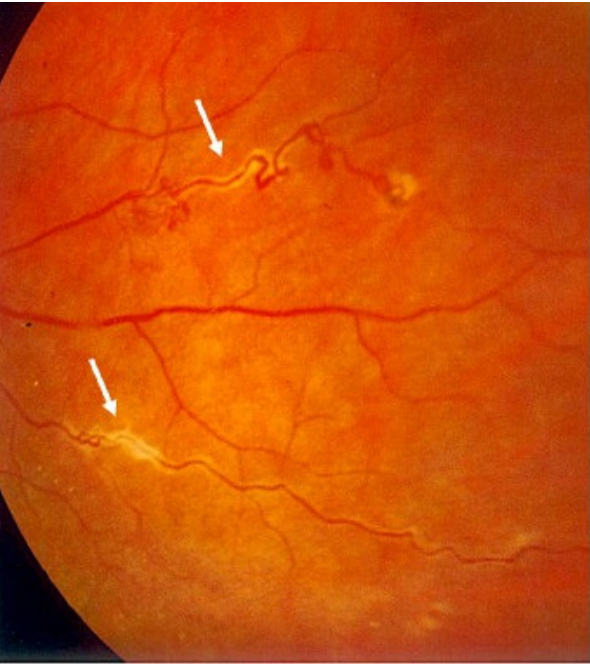
Figure 3. Typical sectorial vascular sheathing resembling “candle wax drippings”.